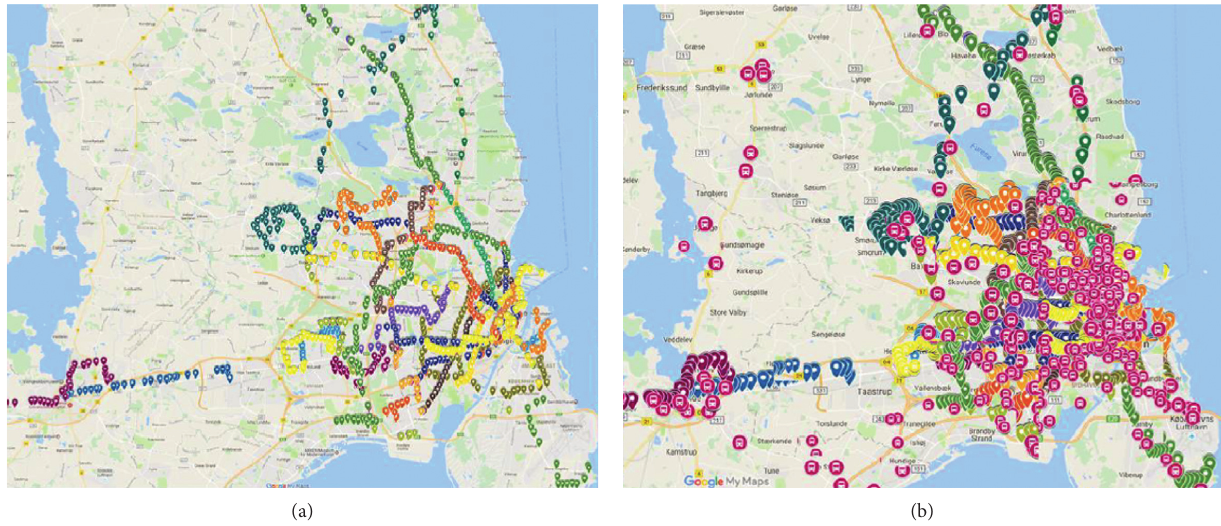
Figure 2: (a) Operational stops on 30 bus routes; (b) with additional mapping of live buses on the